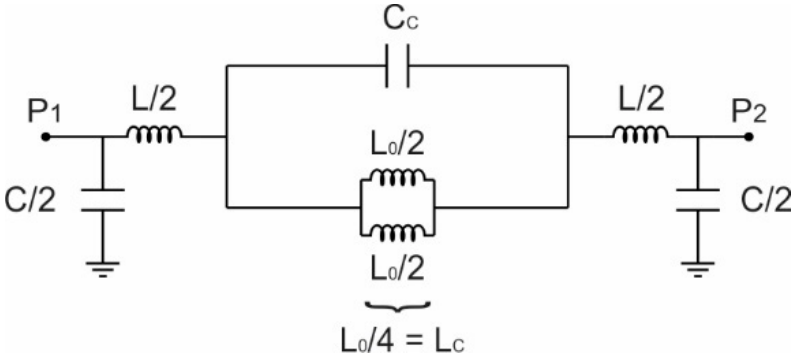
Figure 3. Equivalent circuit model of the proposed sensor.